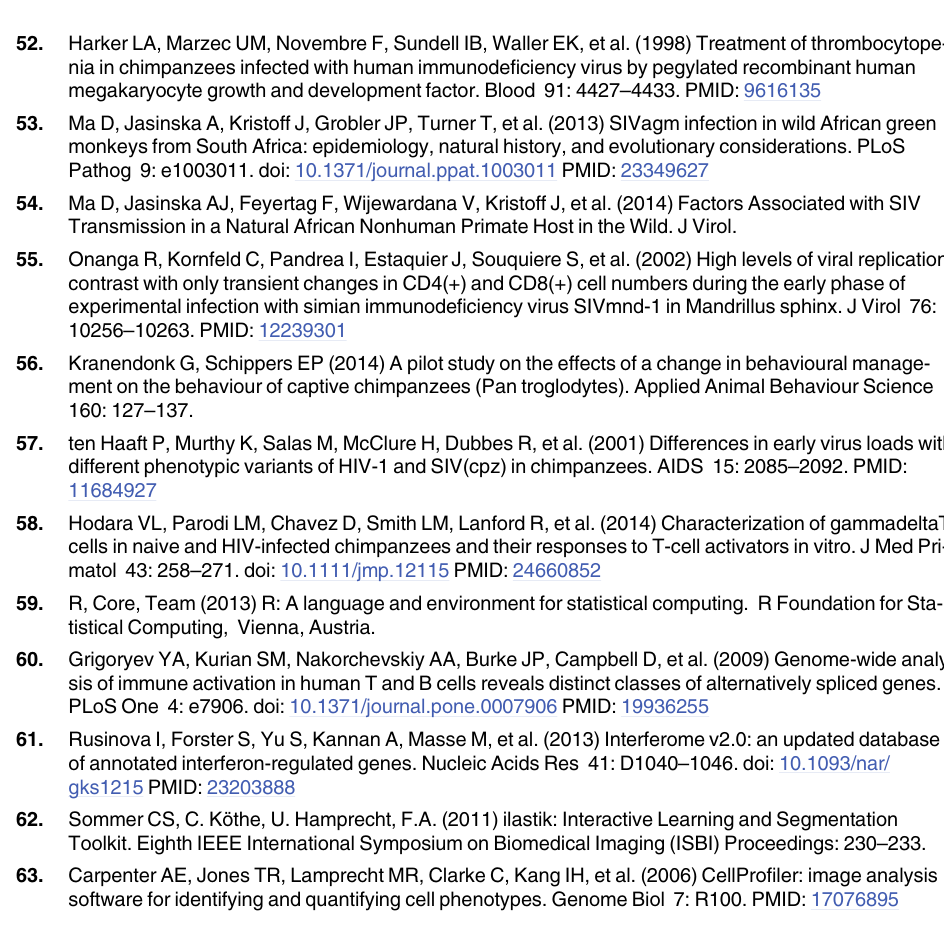
PLOS Pathogens | DOI:10.1371/journal.ppat.1005146 September 11,